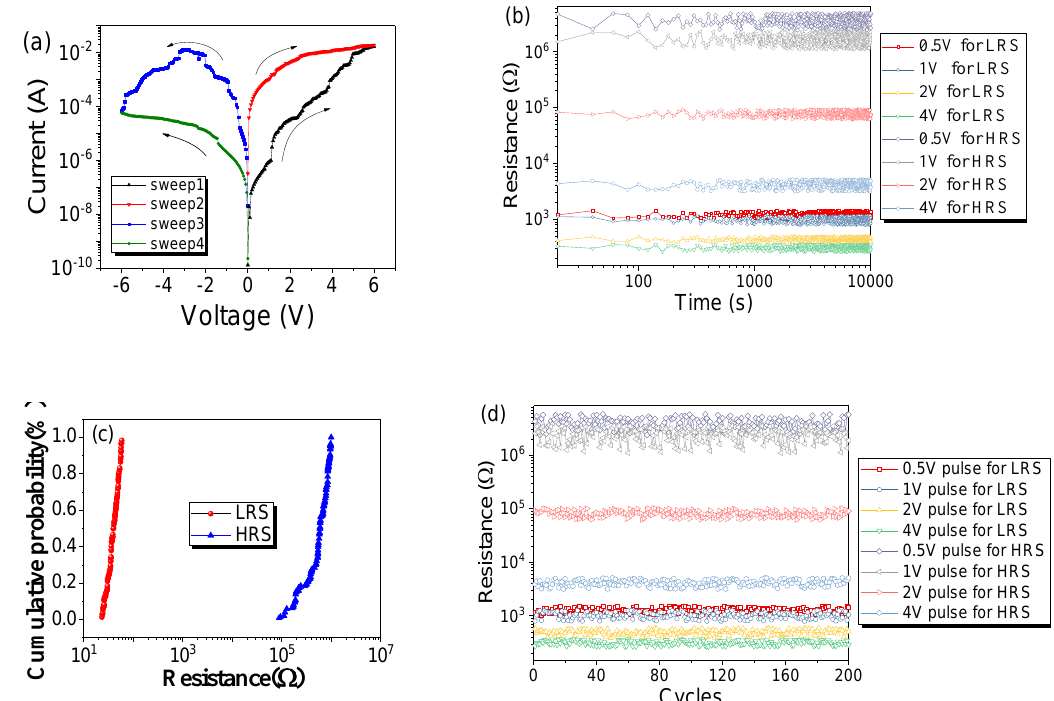
Figure 3. ( a ) I–V curves of the Co–Al LDHs memristor. ( b ) Data retention characteristics of the Co–Al LDHs memristor. ( c ) Cumulative probability for resistance in LRS and HRS under − 2 V. ( d ) Endurance characteristics of the Co–Al LDH memristor.